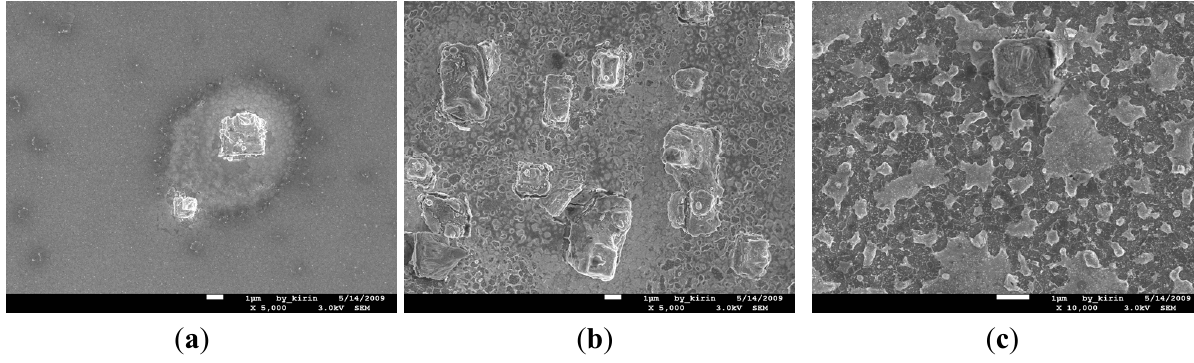
Figure 13. SEM views for the surface morphologies of structures of MgO (1 nm) sample annealed for 5 min at temperatures at 700 °C ( a ); 750 °C ( b ); and 800 °C ( c ); respectively.